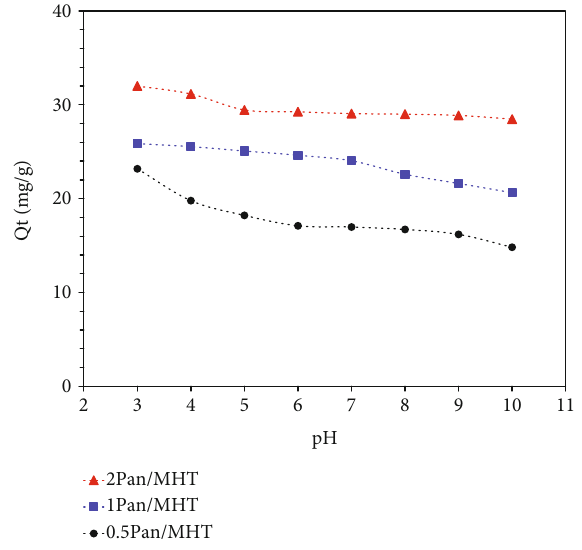
Figure 11: E ff ect of pH on MO adsorption onto 0.5 Pan/MHT, 1 Pan/MHT, and 2 Pan/MHT.